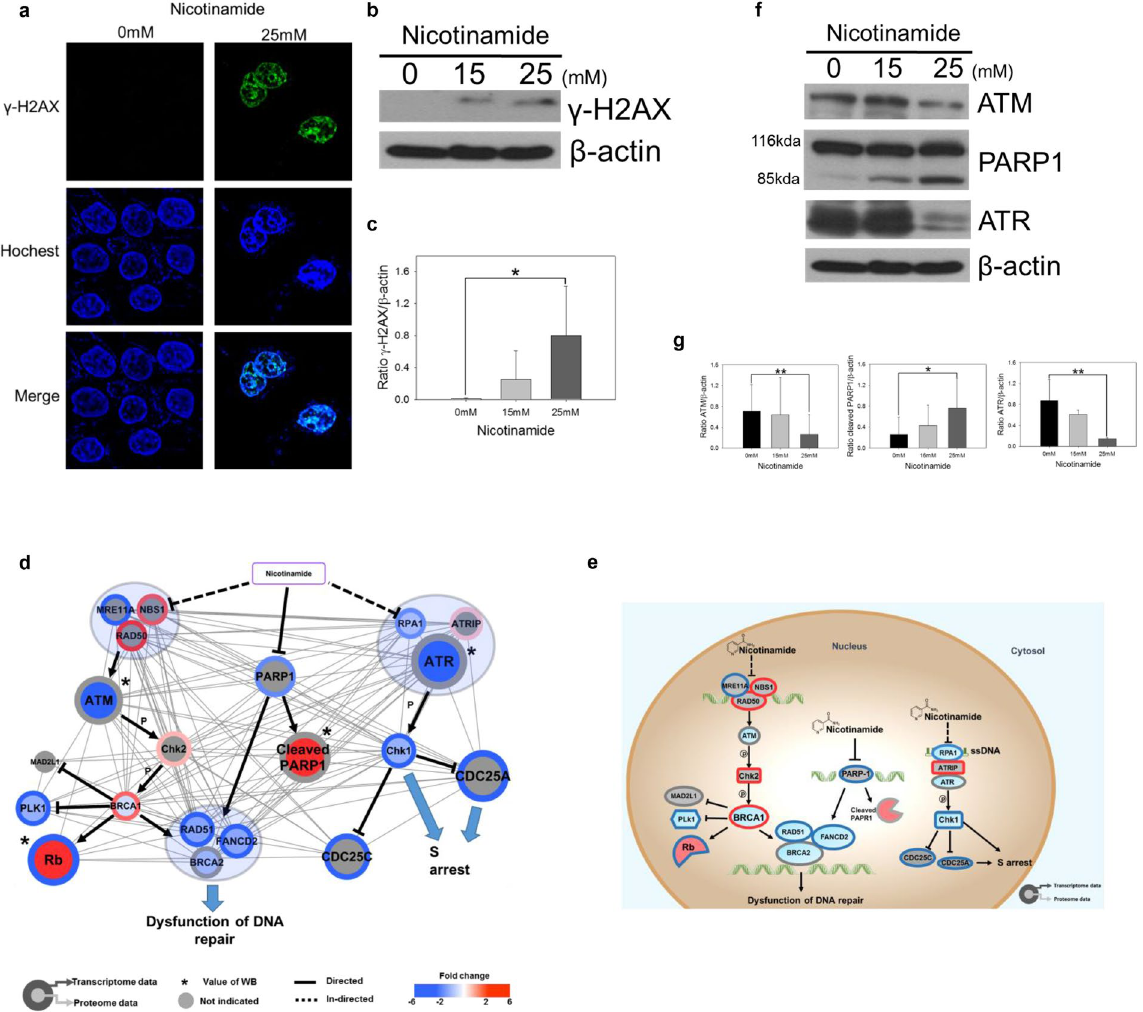
Figure 6. Nicotinamide suppresses DNA repair response. ( a ) Immunofluorescence staining of MDA-MB-231 cells incubated with 0 or 25 mM nicotinamide for 48 h. Green indicates γ -H2AX (H2AFX) foci, and blue indicates nuclei stained with Hoechst 33342. ( b ) Expression of γ -H2AX (H2AFX) in nicotinamide-treated cells were examined via western blotting. ( c ) Densitometry analysis of γ -H2AX (H2AFX) was quantitated using ImageJ. Values were normalized to the levels of β -actin. The data represent the mean ± SD ( * P < 0.05). ( d ) Cytoscape visualization of cell cycle regulatory network. The colors of the border and inside circle indicate the expression levels of transcriptome and proteome data, respectively. Gray edge indicates the relationship of interacted/binding proteins based on the STRING database, whereas a strong solid and dotted line represent the relationships between proteins that are directly and indirectly affected, respectively. The arrows and inhibition symbols represent the activation and repression information. Node with asterisk mark indicates that the protein was assessed by only western blotting without the use of proteome data. There is no significant difference regarding the expression level if the color of the node is gray. Blue circle clustering highlights the complex enzymes of proteins. ( e ) Proposed model of nicotinamide-induced DNA repair interaction network. Networks are represented to reflect proteome, transcriptome and western blotting. Red indicates increased expression, blue indicates decreased expression and gray indicates no significant difference. ( f ) Expression of ATM, PARP1 and ATR in nicotinamide-treated cells was examined via western blotting. ( g ) Densitometry analysis of ATM, PARP1 and ATR was quantitated using ImageJ. Values were normalized to the levels of β -actin. Densitometric analysis was performed using ImageJ. The data represent the mean ± SD ( * P < 0.05, ** P < 0.01). Abbreviations: p - phosphorylation, WB - western